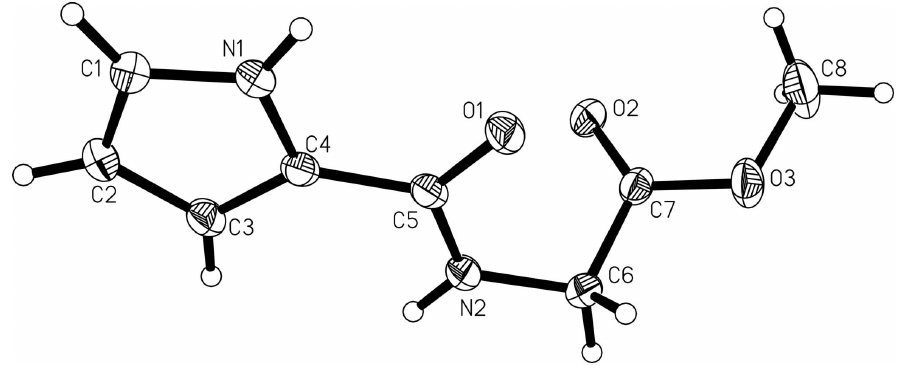
The molecular structure of the title compound, with the atom-numbering scheme. Displacement ellipsoids are drawn at the 30% probability